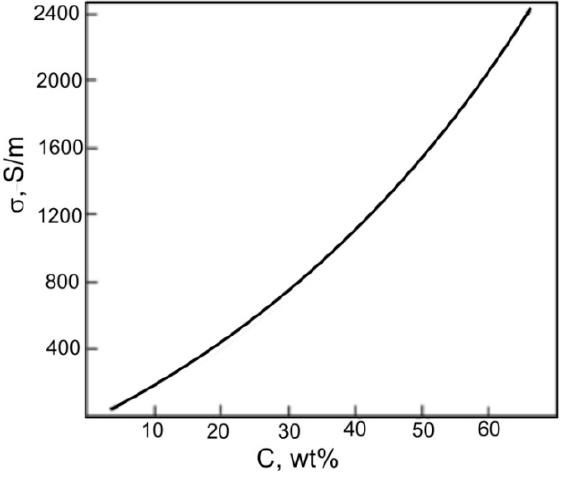
Figure 8. The dependence of the conductivity of shungites on the carbon content according to [64]. Temperature dependences for resistivity ( ρ ), Hall mobility ( μ ), and Hall coefficient ( RH ) in the temperature range Т = 80–500 K in shungite were described in [66]. At room temperature, shungite carbon showed the following parameters: ρ = 3.53 10 − 3 Ω cm, μ = 8.0 cm 2 / V s, RH = − 2.83 10 − 2 cm 3 C − 1 , and charge carrier concentration n = 2.2 10 20 cm − 3 . At the